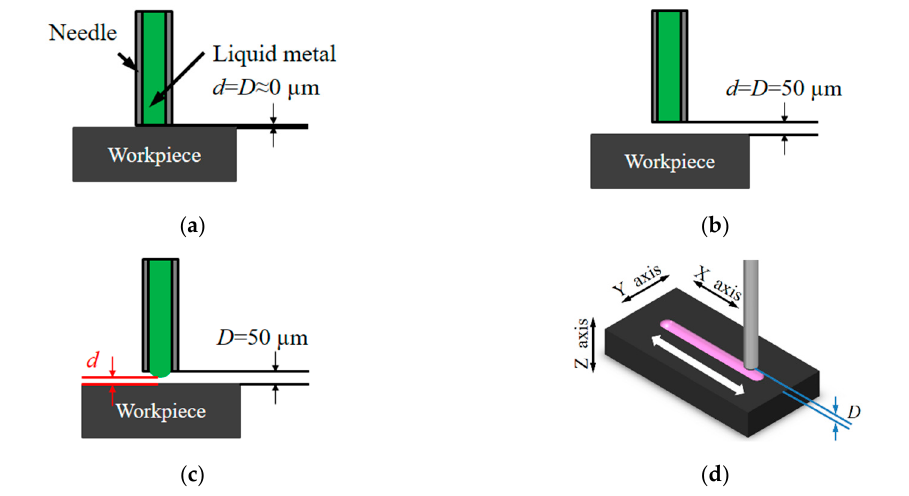
Figure 10. Electrical surface detection and scanning erosion. A low pressure (0.1 atm) is applied via a precision pressure device to ensure that the liquid metal in the needle is just flush with the tip of the needle; then, a small voltage (10 V) is used between them to carry out electrical surface detection using the Z -axis of the stage at a low speed from ( a ) D = 0 μ m ( b ) to D = 50 μ m (retracting the needle) to determine the gap. ( c ) The above electrical surface detection is repeated three times, and the average is taken as the gap position. Additionally, the gap d between the liquid metal and the workpiece is adaptively determined during discharging. ( d ) Horizontal scanning of the workpieces using the XY stage with respect to the liquid electrode at a constant gap distance D for the lateral removal of the material using the liquid electrode.